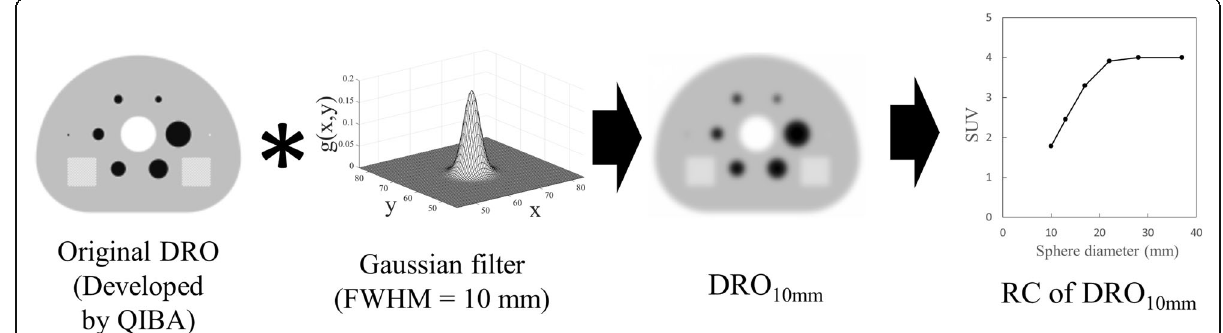
Fig. 1 Development of reference recovery coefficient from digital reference object and three-dimensional Gaussian